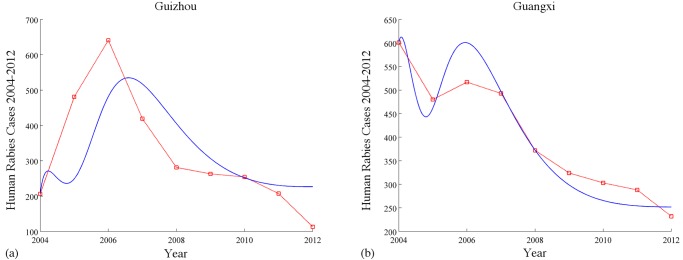
Simulations of the numbers of reported human rabies cases in Guizhou and Guangxi from 2004 to 2012.The solid blue curves are simulation results by our model and the dashed red curves are the numbers of reported cases by China CDC [25]. Values of parameters: A
1 = 3 × 106, A
2 = 8.5 × 105, B
1 = 7.223 × 105, B
2 = 5.143 × 105, λ1D=λ2D=0.33, λ1H=λ2H=2, σ1D=σ2D=10, σ1H=σ2H=6, γ1D=γ2D=0.4, γ1H=γ2H=0.475, m1D=m2D=0.345, m1H=m2H=0.00662, k1D=0.07, k2D=0.05, k1H=k2H=0.5, μ1D=μ2D=μ1H=μ2H=1, β1D=2.7×10−6, β2D=2.4×10−6, β1H=1.15×10−11, β2H=2.8×10−11, ϕ12S=ϕ12E=ϕ12I=ϕ12V=0.2, ϕ21S=ϕ21E=ϕ21I=ϕ21V=0.15, ψ12S=ψ12E=ψ12V=0.15, ψ21S=ψ21E=ψ21V=0.2, ψ12I=ψ21I=0.